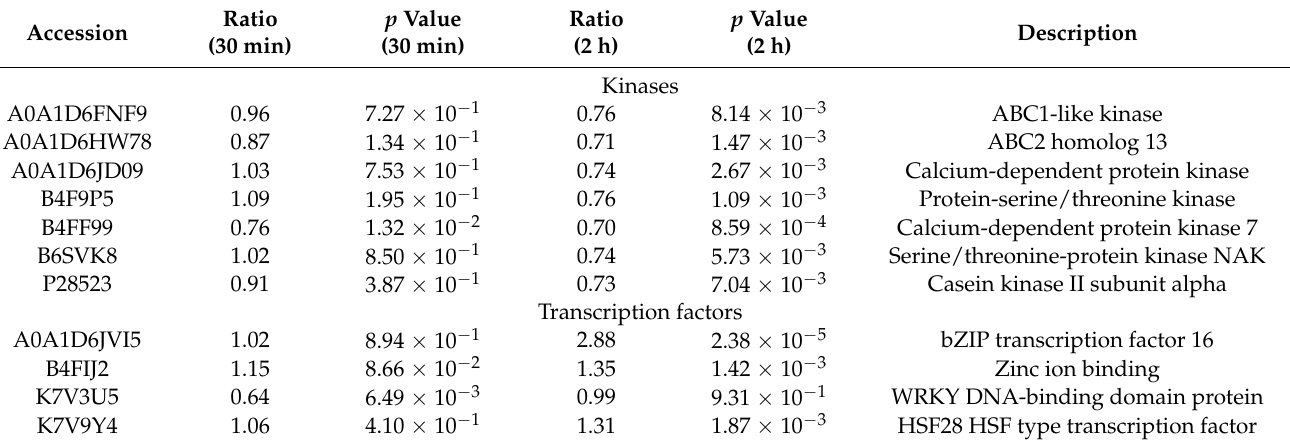
Table 1. Cold-responsive kinases and transcriptional factors (at the protein abundance levels). “Ratio” refers to protein abundance ratio of treated/control. “ p -value” refers Benjamini–Hochberg adjusted p -value.